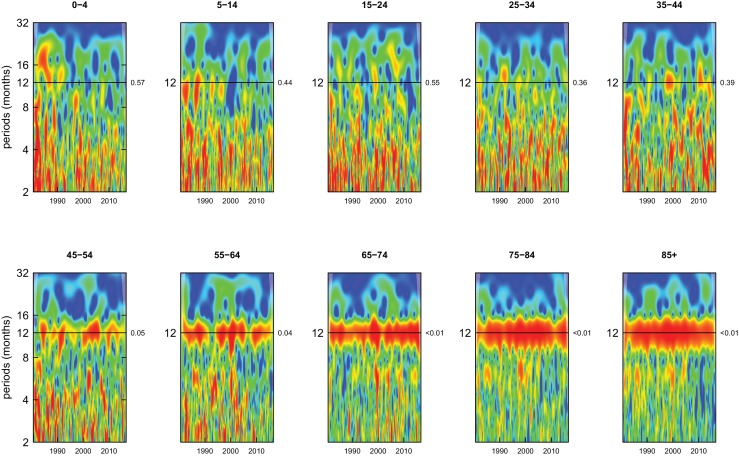
Wavelet power spectra for national time series of genitourinary disease death rates for 1980–2016, by age group for females.Wavelet power values increase from blue to red. The shaded regions at the left and right edge of each box indicate the cone of influence, where spectral analysis is less robust. P-values for the presence of 12 month seasonality are to the right of each figure at the 12 month line.